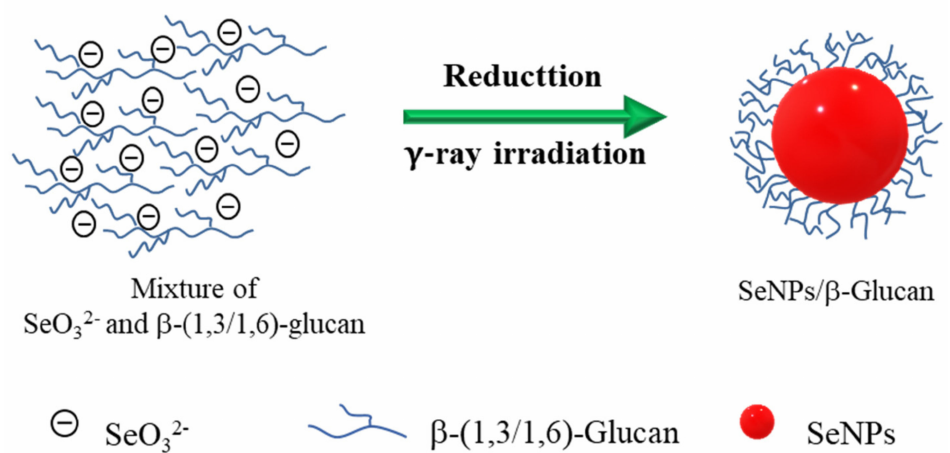
Figure 8. Schematic representation of the synthesis of SeNPs capped by β -glucan using gamma irradiation for reducing Se 4+. 3.2. Stability of the SeNP/ β -glucan solution by